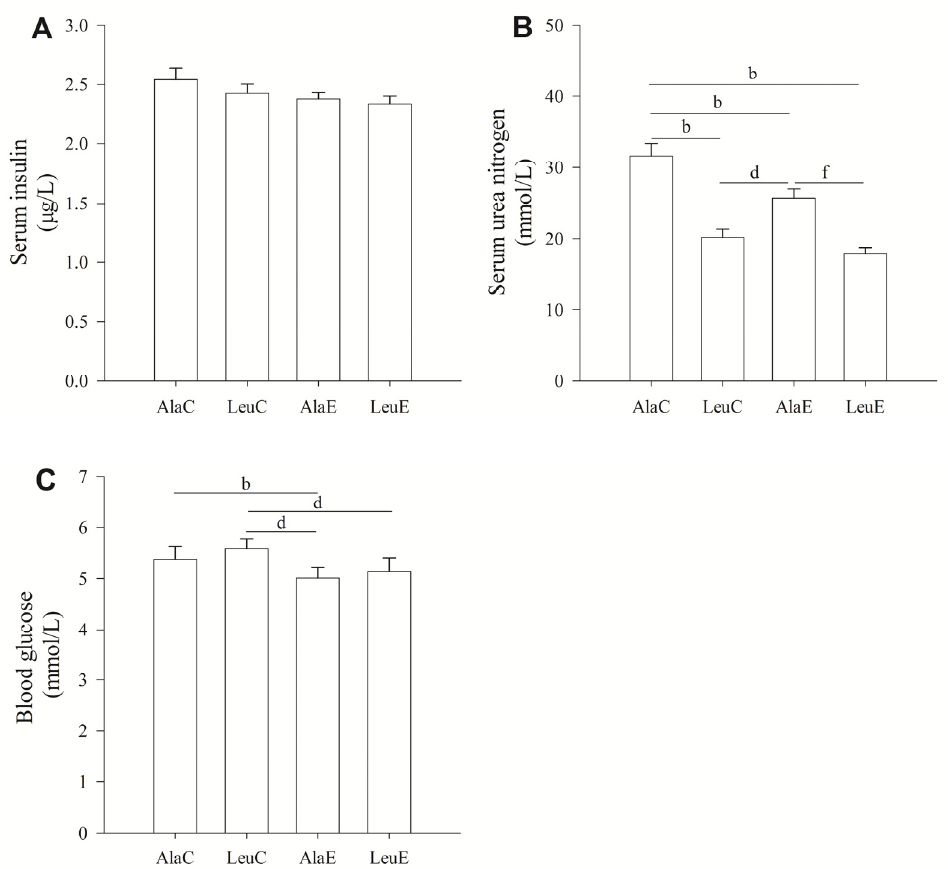
Figure 2. ( A ) Effects of leucine supplementation and exercise on serum insulin; ( B ) serum urea nitrogen; and ( C ) blood glucose in pre-senescent mice. AlaC: alanine supplementation group; LeuC: leucine supplementation group; AlaE: alanine supplementation + exercise training group; LeuE: leucine supplementation + exercise training group. Values are provided as mean ± standard deviation for each group ( n = 7–10). a: p < 0.05 versus the AlaC group; b: p < 0.01 versus the AlaC group; c: p < 0.05 versus the LeuC group; d: p < 0.01 versus the LeuC group; e: p < 0.05 versus the AlaE group; f: p < 0.01 versus the AlaE group.